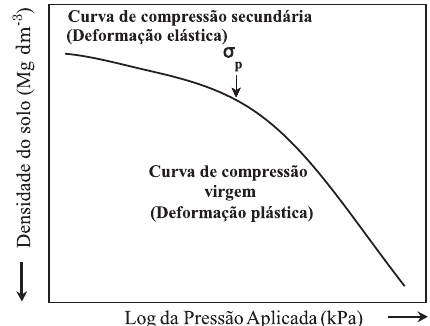
figura 1. Curva de compressão do solo. adaptado dias junior (1994).